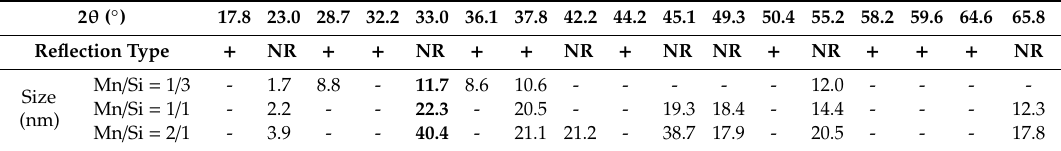
Table 6. Summary of XRD results for Mn / Si = X (1 / 3; 1 / 1; 2 / 1) catalyst showing crystallite size with di ff raction angle (2 θ ). ( + ) represents standard reflections of Co 3 O 4 ; (NR) represents new